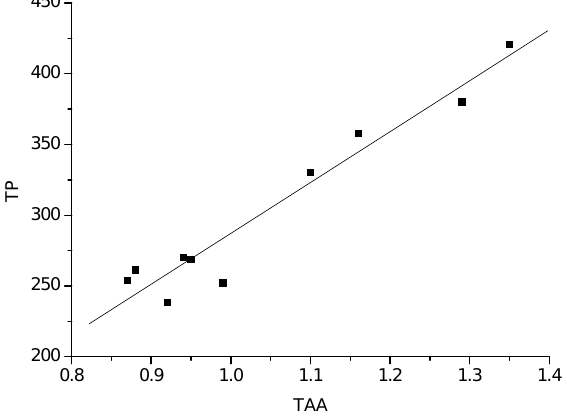
Figure 1. Correlation between total phenolics and total antioxidant activity.